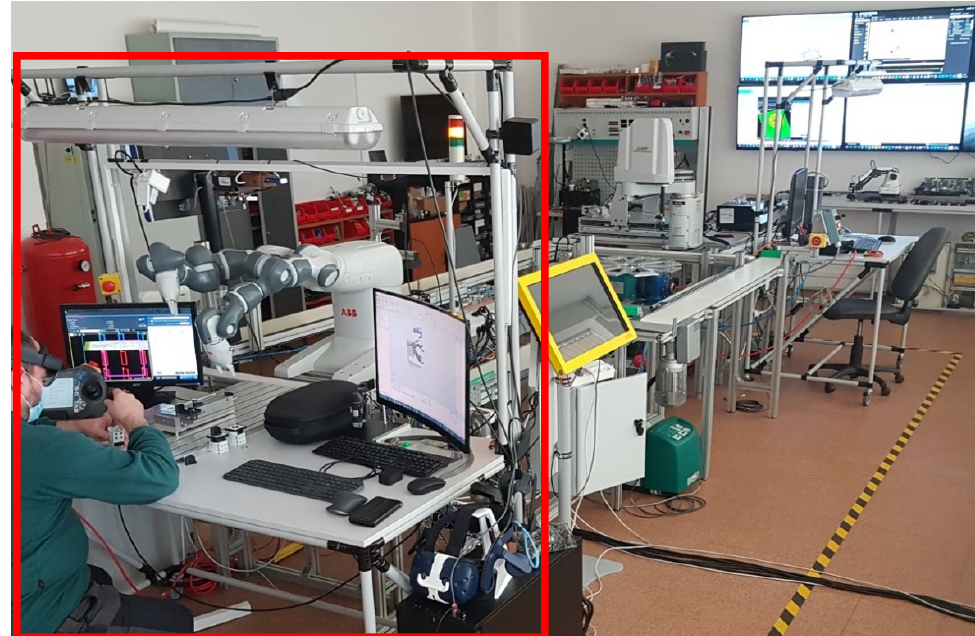
Figure 3. The experimental SMART manufacturing system; red frame: the workplace with an assisted assembly work cell with collaborative robot ABB Yumi and Microsoft Hololens 2 mixed reality device.